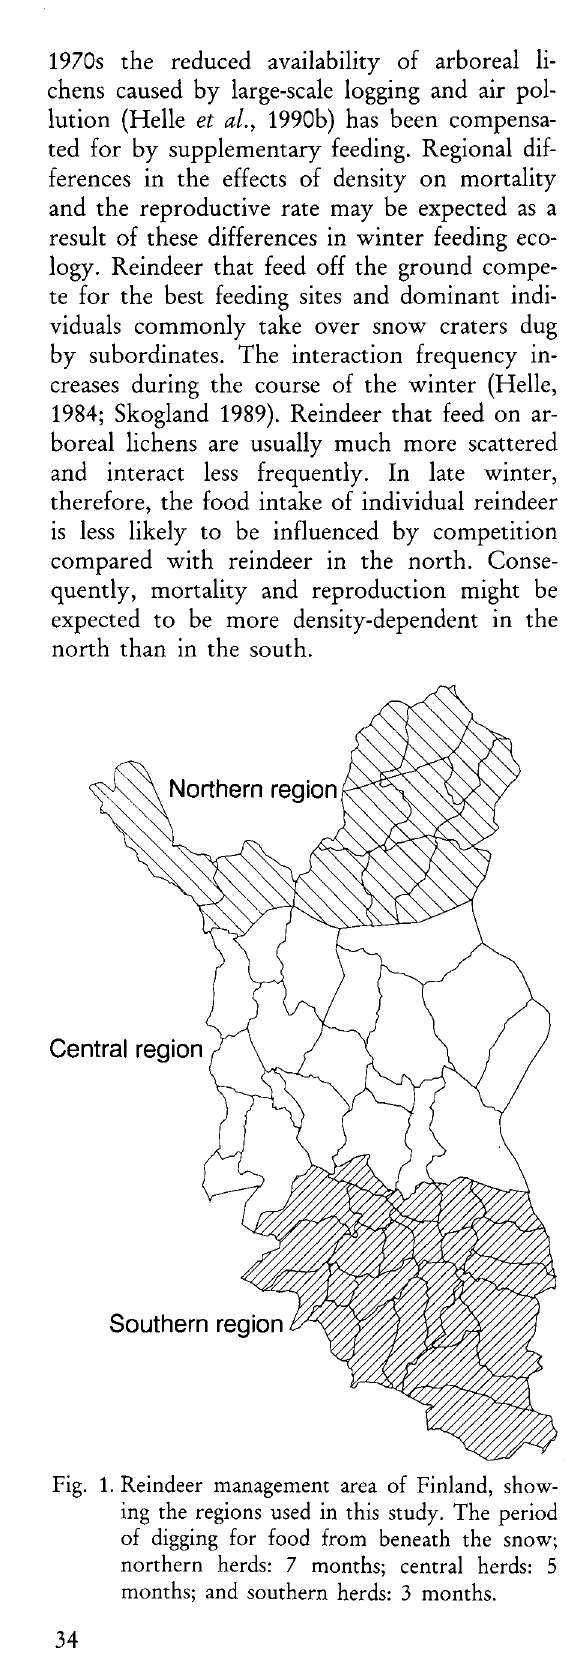
Fig. 1. Reindeer management area of Finland, show ing the regions used in this study. The period of digging for food from beneath the snow; northern herds: 7 months; central herds: 5 months; and southern herds: 3